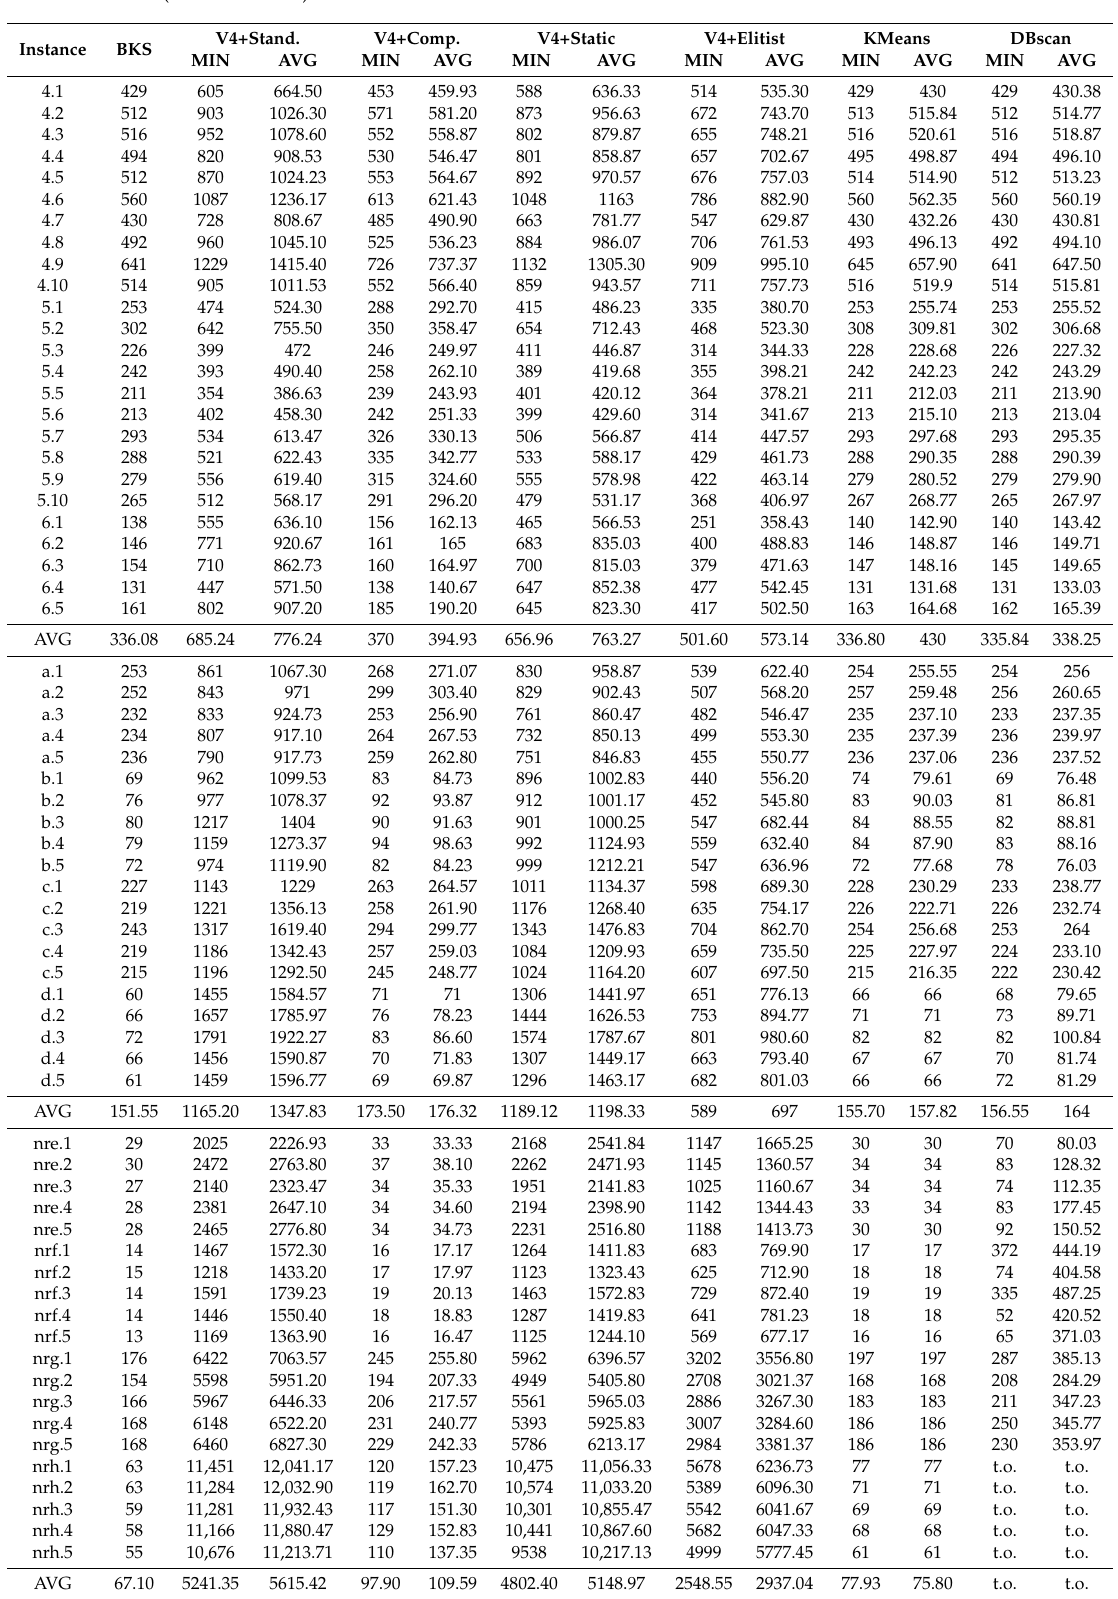
Table A8. CSA/SCP—VShape 4—Two-steps vs. KMeans vs. DBscan: Groups NRE, NRF, NRG, and NRH (t.o = time